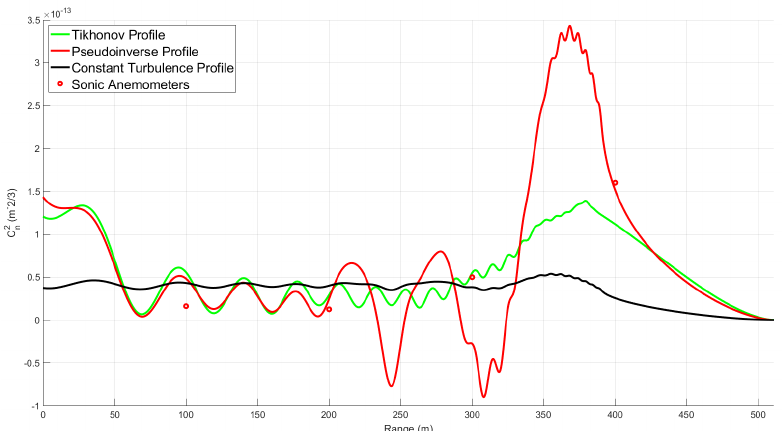
Figure 9. 25 July 22:00 UTC turbulence profile with α = 30. At this time, the BLS measured a C 2 n of 4.0 × 10 − 14 m − 2/3 , which is multiplied by the influence function to represent a profile under constant